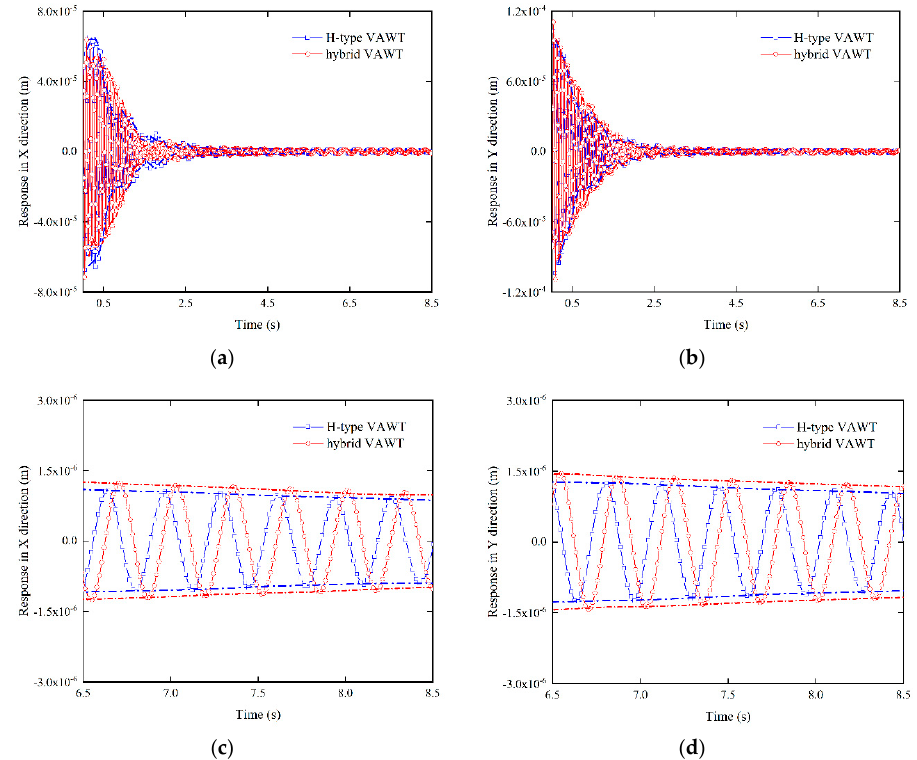
Figure 18. Forced transient responses of the 4 m ‐ mast H ‐ type and hybrid VAWTs in ( a ) X ‐ and ( b ) Y ‐ directions, and their steady ‐ state responses in the ( c ) X ‐ and ( d ) Y ‐ directions from 6.5 to 8.5 s. Table 15. Comparison of the maximum steady ‐ state response amplitudes of the 4 m ‐ mast H ‐ type and hybrid VAWTs in X ‐ and Y ‐ directions from their SEMs.